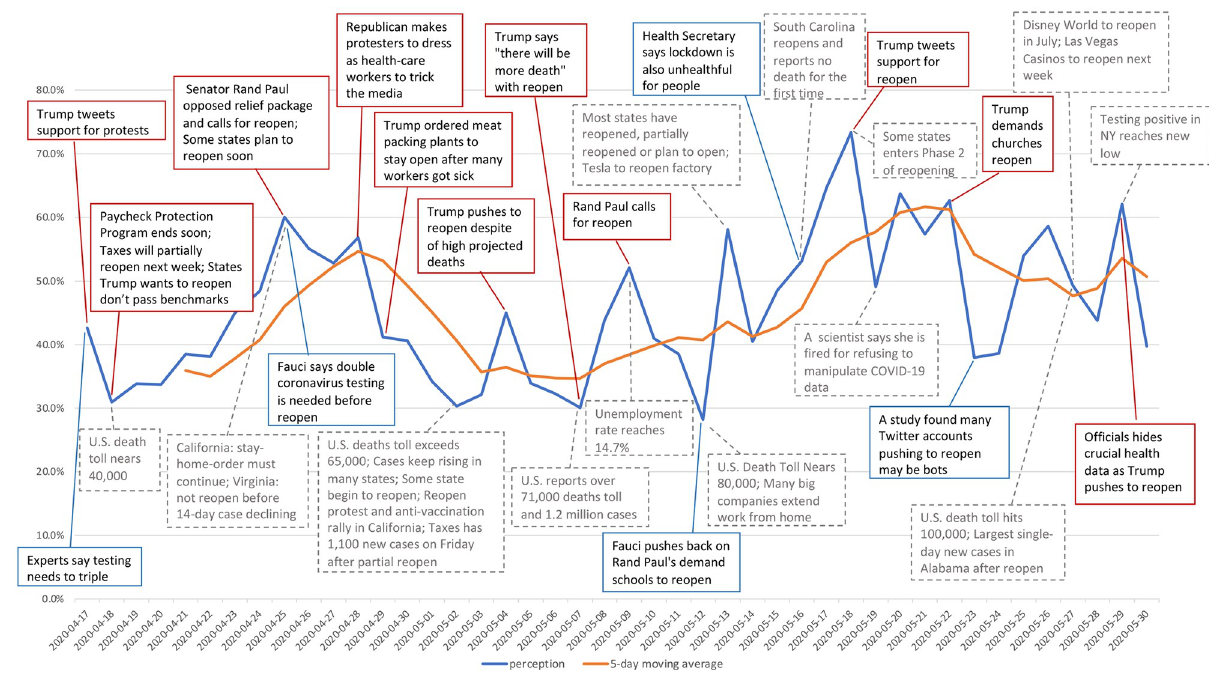
Fig 3. Daily perception and breaking